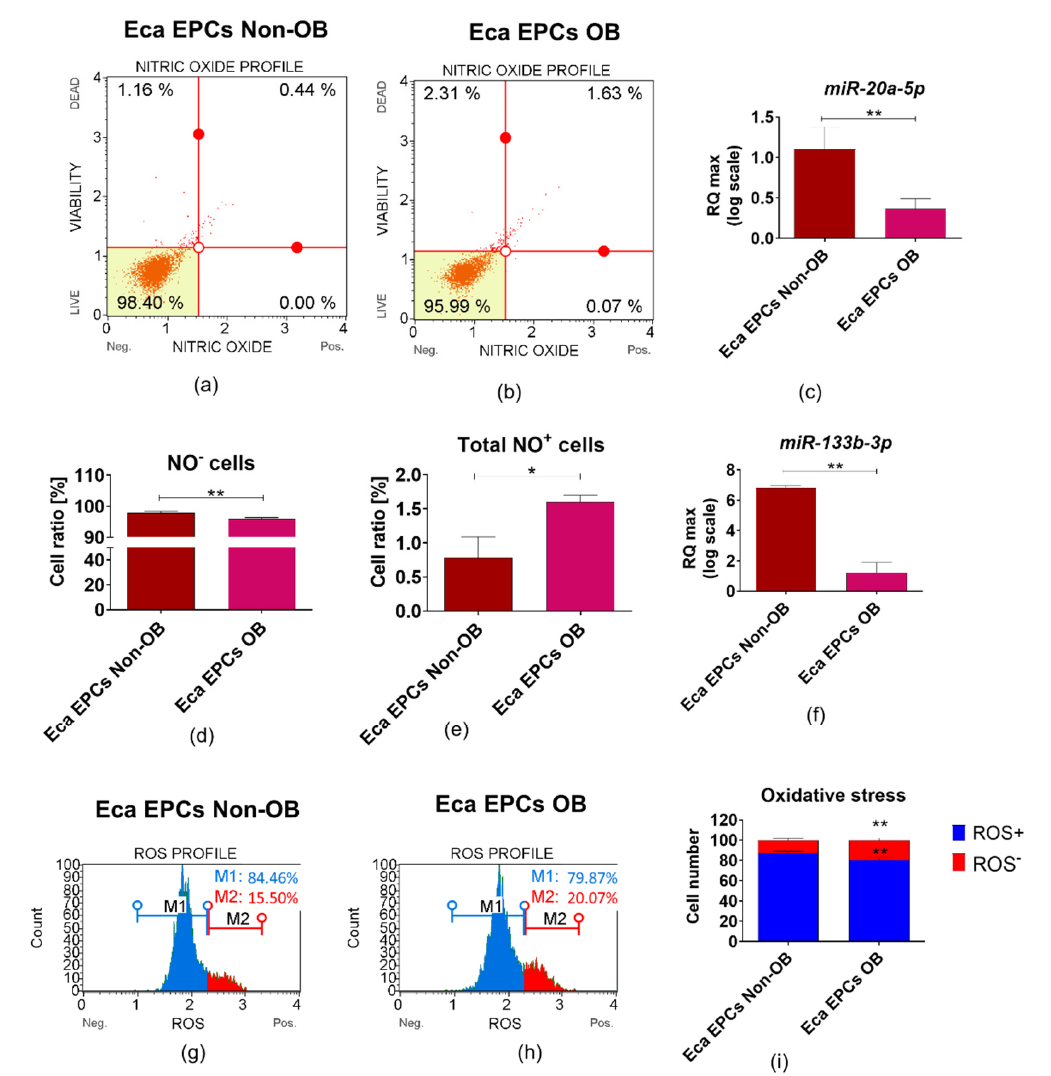
Figure 12. The analysis of the oxidative status in equine endometrial progenitor cells (Eca EPCs) isolated from non-obese mares (non-OB) and obese mares (OB). Representative dot plots show the distribution of cells based on intracellular accumulation of nitric oxide—NO ( a , b ), while column graphs show statistical analyses ( d , e ). The cells located in the left bottom corner of dot-plot graphs did not accumulate NO (Live), while viable cells that accumulated NO are located in the right bottom corner. Dead cells are located in the upper part of dot-plot—in the left corner NO negative cells (NO − ) while in the right NO positive cells (NO + ). The increased overall percentage of NO positive cells noted in EPCs OB corresponds with the lowered expression of miR-20a ( c ) and miR-133b ( f ). The distribution of cells based on reactive oxygen species (ROS) accumulation is visible on histograms ( g , h ). Cells that did not accumulate intracellular ROS are marked with a blue gate, while ROS positive cells are marked with a red gate. The comparative analysis confirmed oxidative stress in Eca EPCs OB ( i ). Means ± SD. * p -value < 0.05 and ** p -value < 0.01.